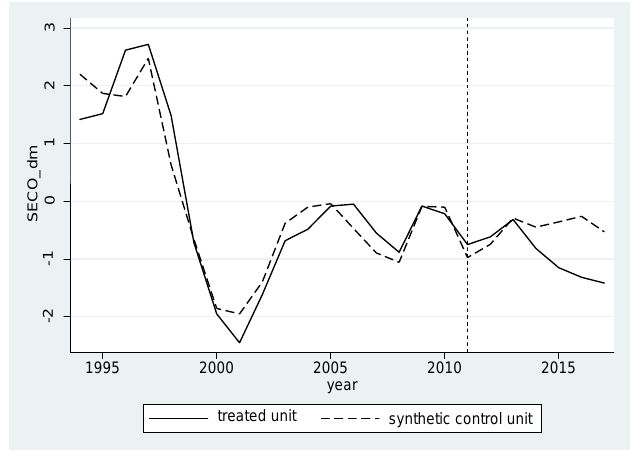
Figure 10. Outcome specification 2.